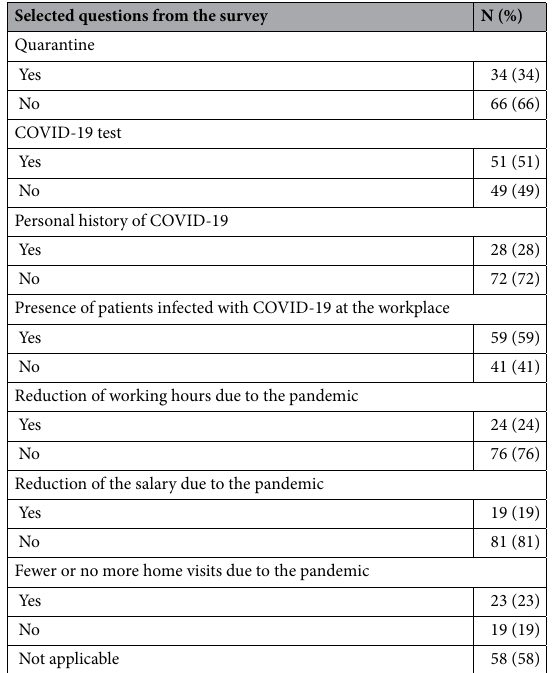
Table 2. Responses given by the examined physiotherapists to selected questions from the survey concerning the COVID-19 pandemic.